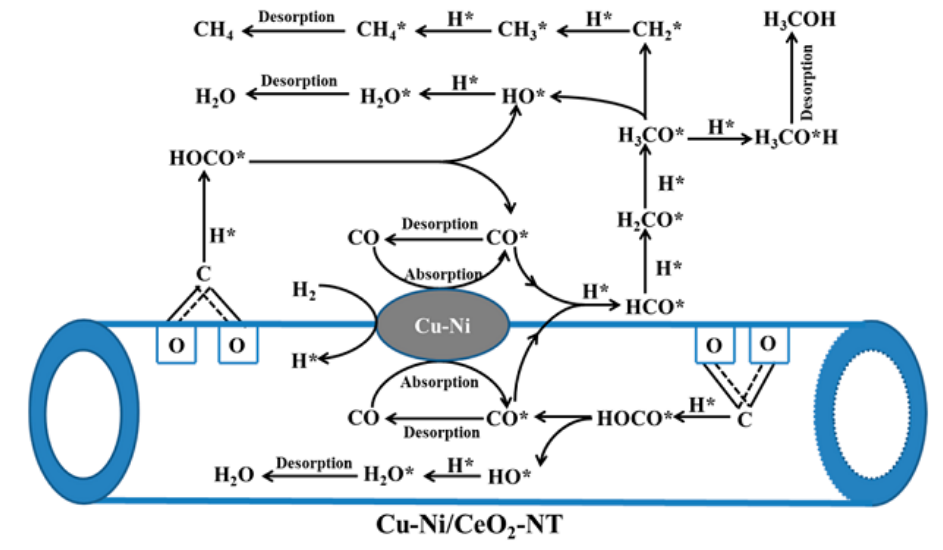
Figure 12. Details of the CO 2 conversion and product selectivity, along with reaction conditions of